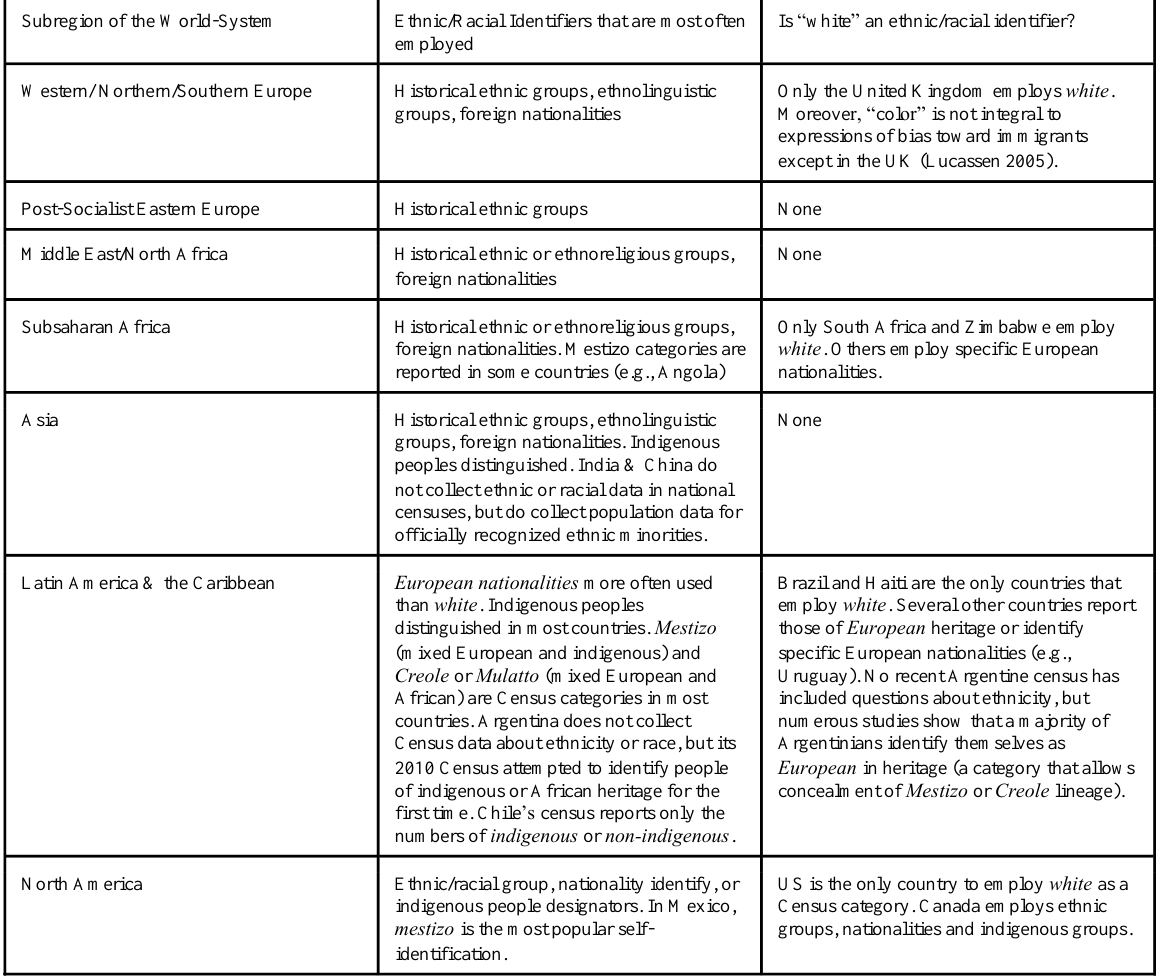
Table 10. Ethnic/Racial Identifiers Employed in National